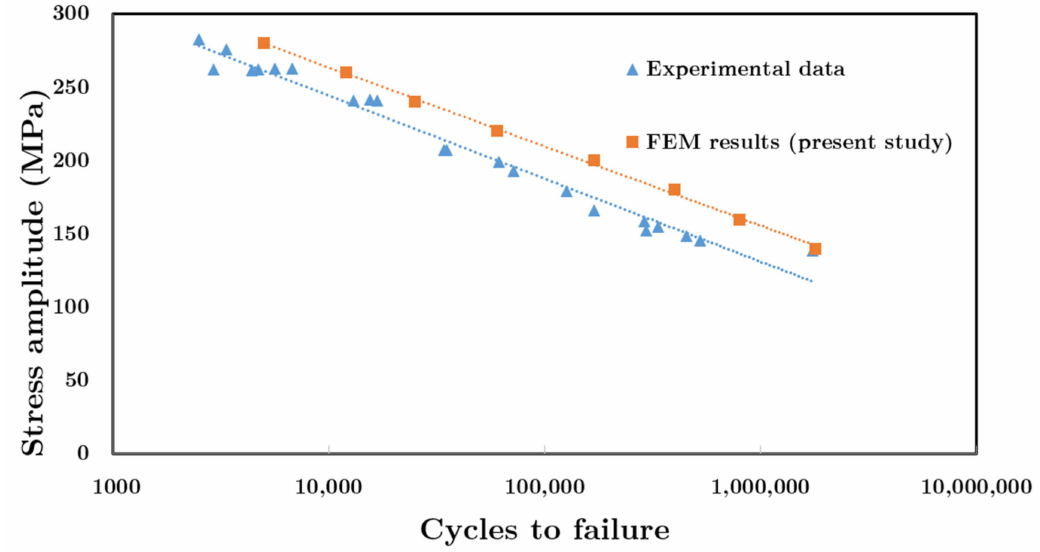
Figure 5. Stress amplitude versus cycles for undamaged aluminum 6061-T6 for both FEM in the present study and experimental data